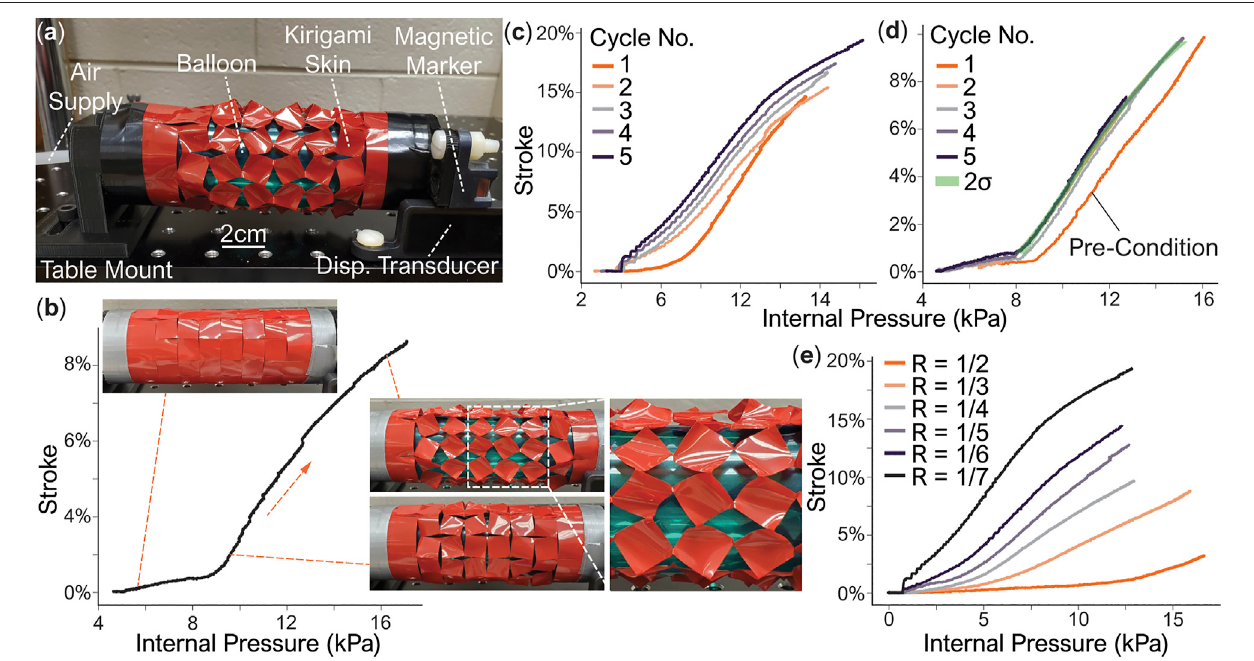
FIGURE 5 | Free stroke testing results from the kirigami-skinned actuators. (A) The test setup. (B) A pressure-stroke curve of a prototype with R (cid:1) 1/6 and the correspondingskindeformationpattern.Thetwodeformationphasesareevident. (C) Cyclicloadingresponsesfromthisprototype.Eachloadingcycleachievesahigher strokethanthepreviousone. (D) Anothercyclicloadingresult.Inthiscase, theprototypeispressurizedto10%strokeinthe fi rstpre-conditioncycle,andthenusedwith a smaller stroke in the subsequent cycles. The standard deviations of Cycles 2-5 are highlighted, showing a repeatable performance. (E) The measured performance of actuator prototypes with different cut ratios. Experiment images adapted from Ianucci and Li, 2020 with permission.